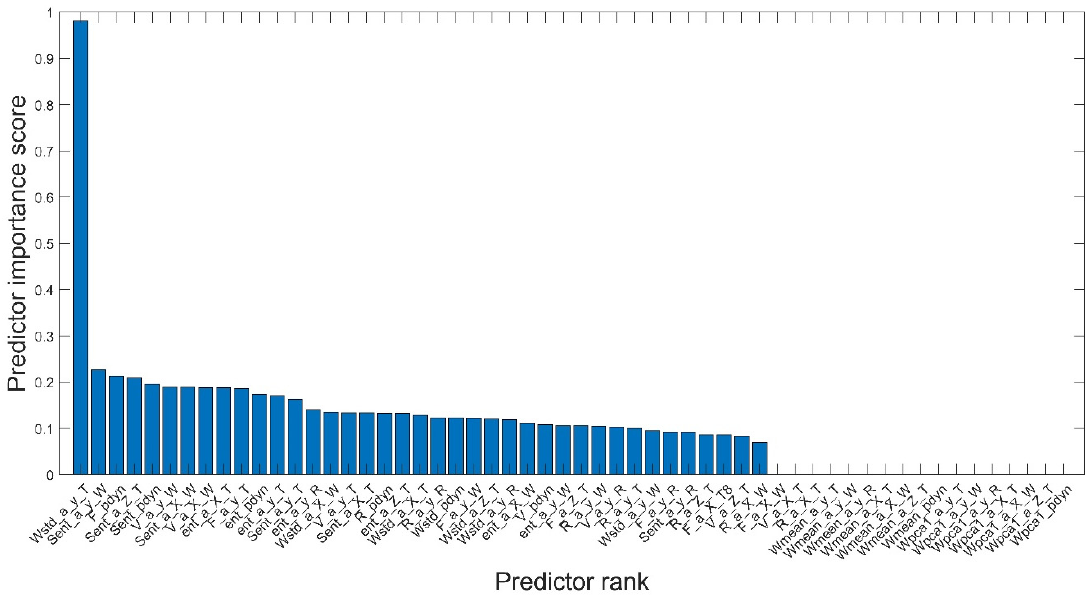
Figure 6. Ranking of features that meet the condition of most significant applicability with minimum redundancy—based on data obtained under stationary and non-stationary pump conditions. Table 1. The most significant signal features for assessing pump wear